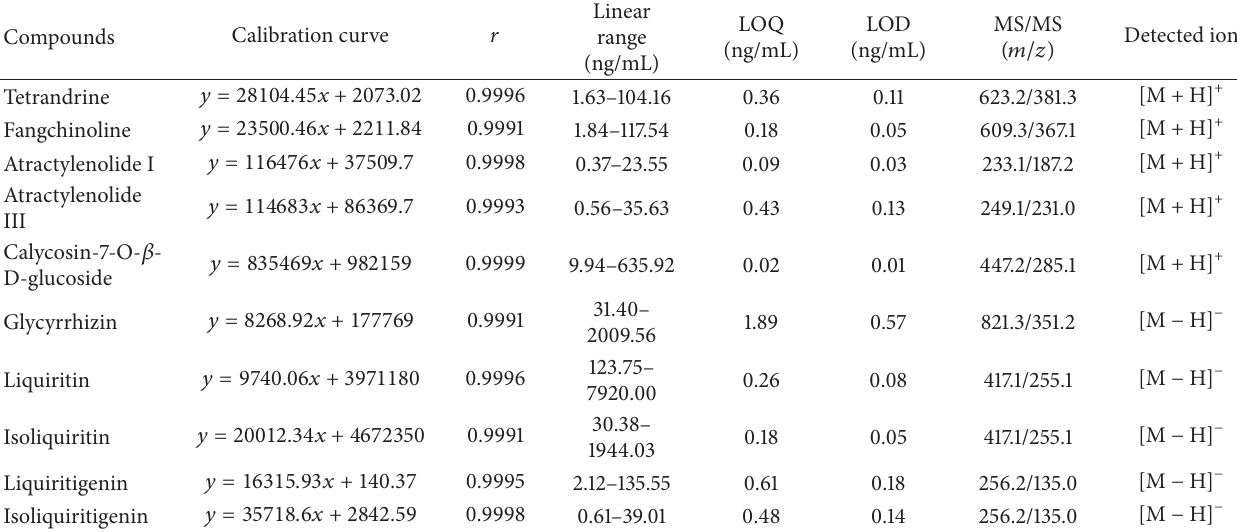
Table 2: Calibration curves, LOD, and LOQ of the 10 major compounds.